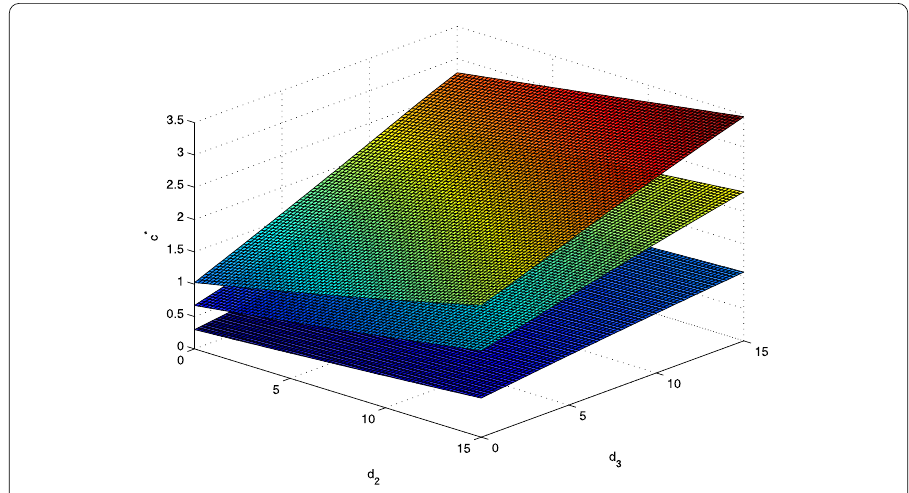
Figure 4 The surface of c ∗ ( d 2 , d 3 ) for the second model. Let α = 1, β = 3, S 0 = 1, k = 0.2, and γ = 1.5 be fixed. Three surfaces from bottom to top are generated by taking τ = 4,1,0.2, respectively. We can see that the